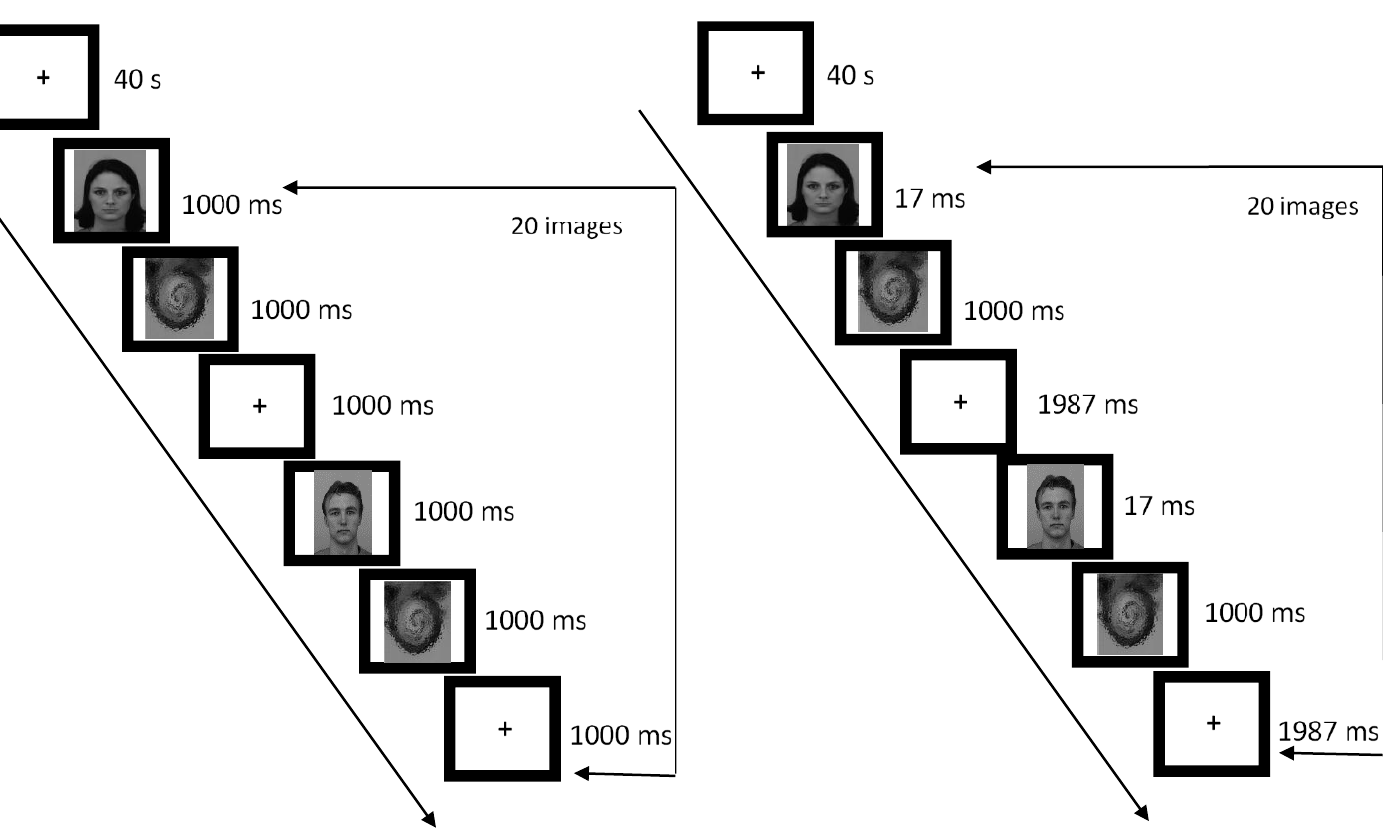
Figure 1. A depiction of sequence of events for Conscious (left) and Unconscious (right) trials. Each trial was 3000 ms in duration; there were 20 trials per one-minute block, and three blocks per fMRI run. A separate fMRI run was performed for each emotion type (Angry, Fearful, and Neutral) at each duration type (Conscious and Unconscious).